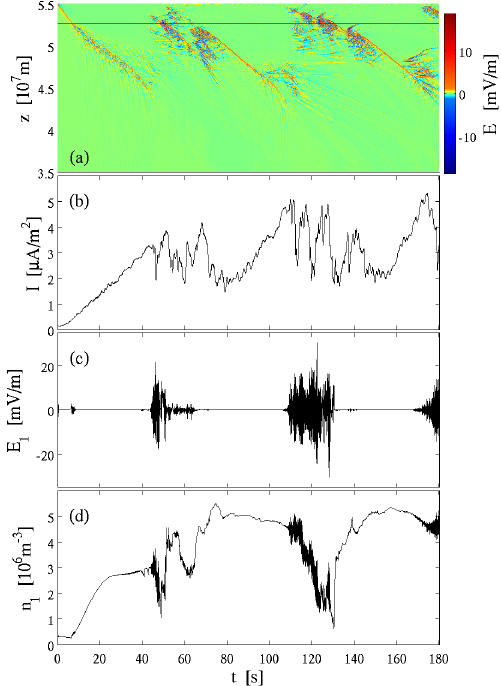
Figure 2. Electric field, current, and density as functions of time in the run with V p , I = − 400V and 4 × 10 7 m − 3 . (a) The electric field in a z − t diagram for z ≥ 3 . 5 × 10 7 m. (b) Current density scaled to the ionospheric side of the system. (c) Electric field at z = 5 . 265 × 10 7 m. (d) Plasma density at z = 5 . 265 × 10 7 m. The line at z = 5 . 265 × 10 7 m in panel (a) , corresponding to an altitude of 2470km, indicates the position for which the electric field and density are shown in panels (c) and (d)